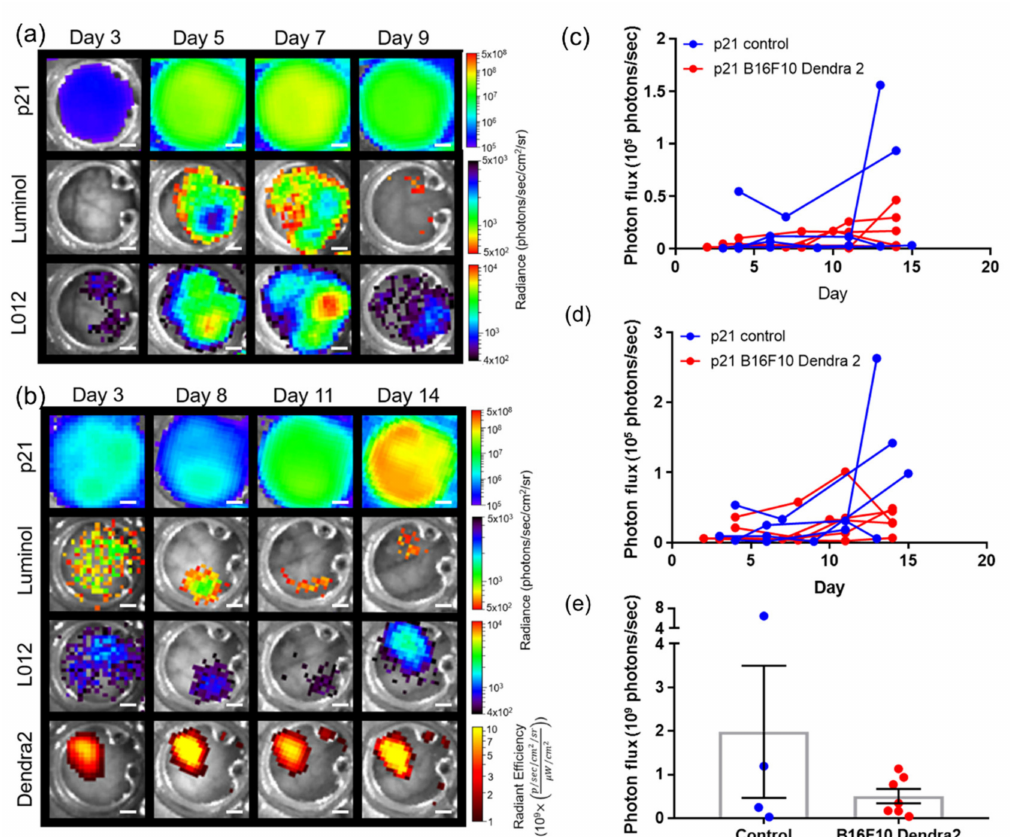
Figure 4. In vivo bioluminescence unmixing in p21-FLuc transgenic skin window chamber animals ( a ) without ( n = 4 animal) and ( b ) with B16F10 Dendra2 reporter cells ( n = 6 animals). Dendra2 fluorescence monitors B16F10 tumor growth. Reporter p21 activation is monitored by FLuc bioluminescence following D-luciferin i.p. injection. Innate immune cell infiltration imaged by bioluminescence using luminol and L-012; scale bar represents 2 mm. Window chamber bioluminescence quantification of ( c ) luminol, ( d ) L-012, and ( e ) p21 activation in p21-FLuc window chamber-bearing animals without (blue) and with B16F10 Dendra2 reporter cells